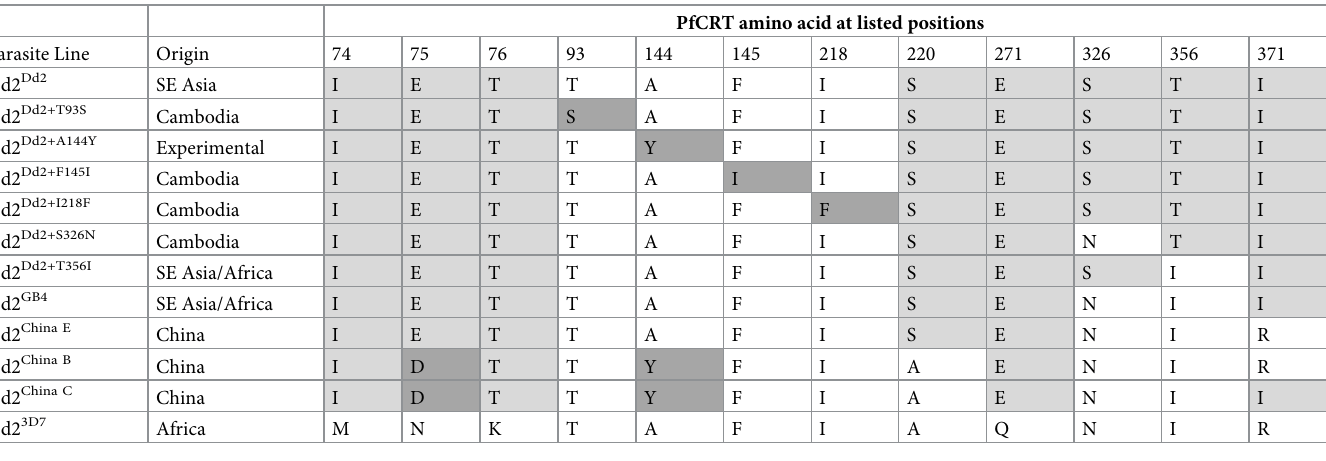
PfCRT amino acid at listed positions